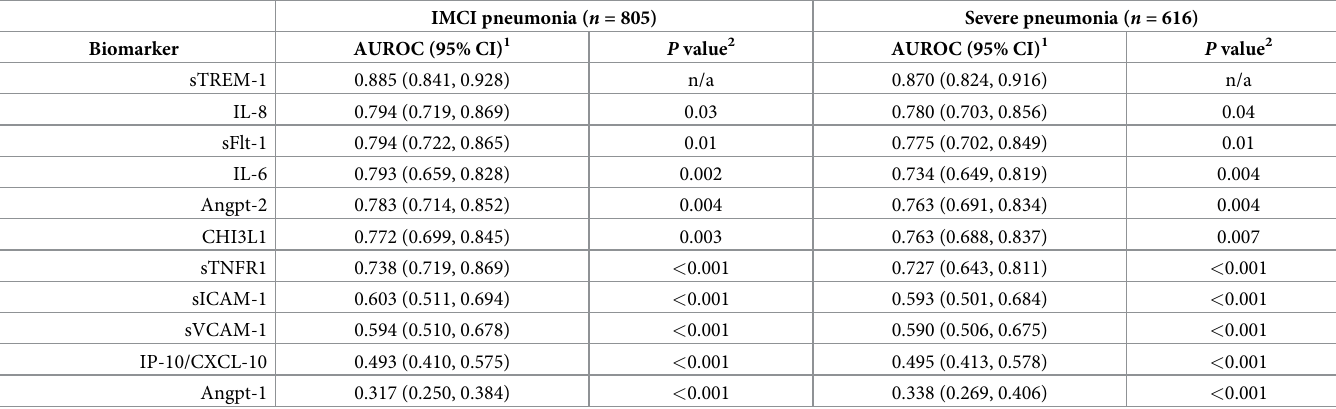
Table 2. AUROC for the outcome of 48-hour mortality for single immune and endothelial activation marker